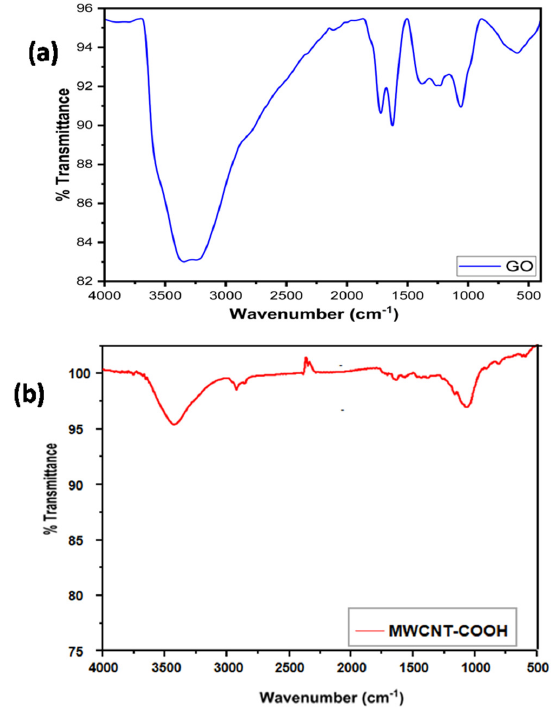
Figure 2. FT − IR spectra of ( a ) GO, ( b ) MWCNT − COOH.